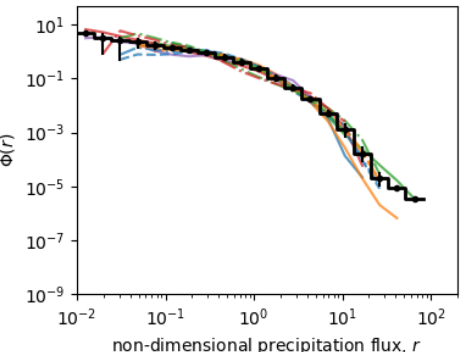
Figure 4. The rescaled rainfall rate distributions for the five CDNC- concentration intervals (colours) and aerosol concentrations (line styles) as functions of the normalised rainfall rate, plotted according to the conventions established in Fig. 2, and the average histogram (black line). The vertical black bars in each bin of the histogram show the inter-model spread, i.e. the range of values obtained by defining an average histogram for each model experiment sepa- rately (and hence the sensitivity of the dimensionless distribution to aerosol